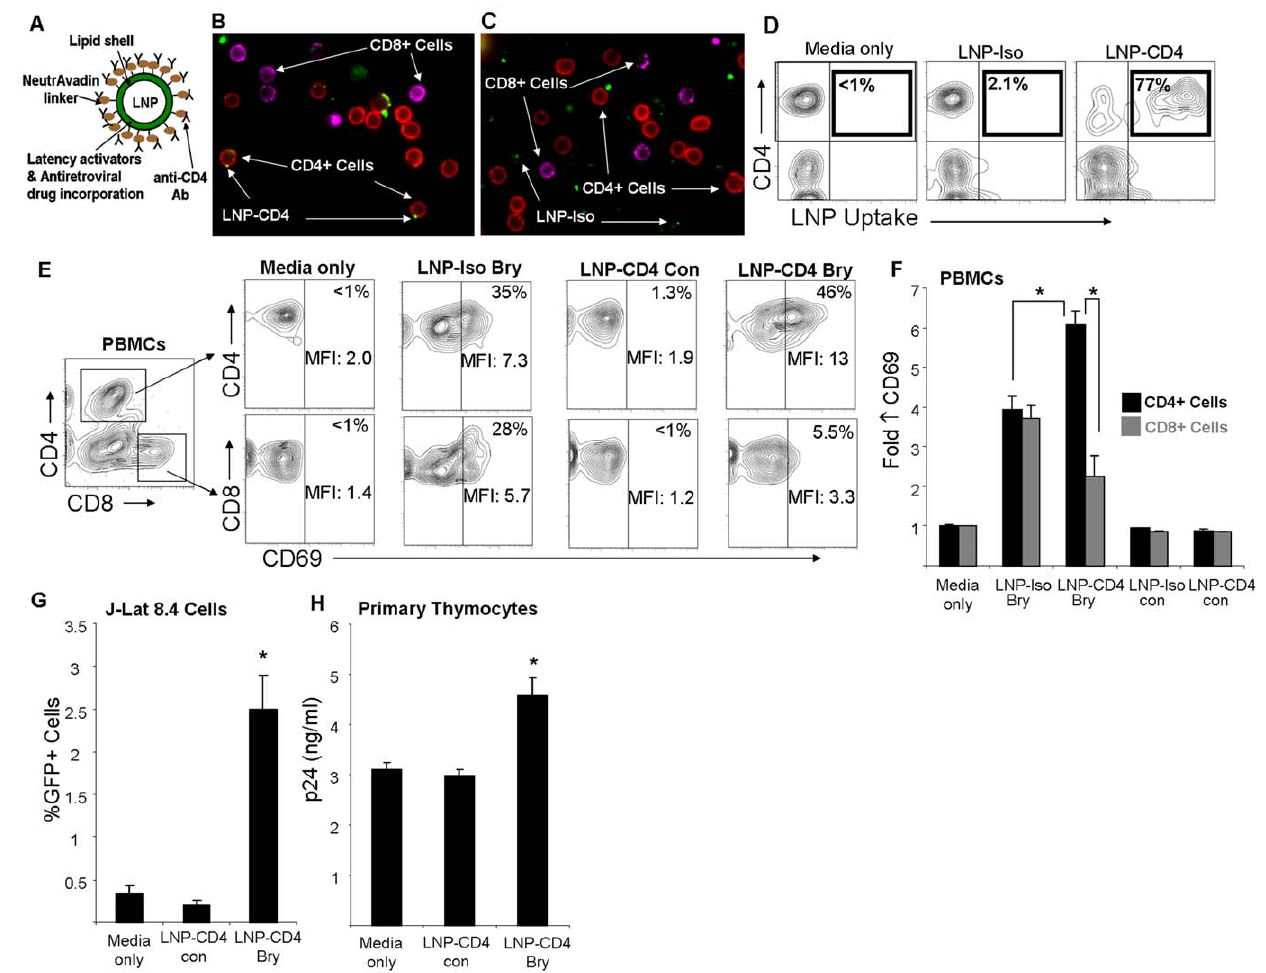
Figure 4. Targeting LNP to primary CD4 + cells and activation of latent virus expression. (A) Schematic representation showing construction of the LNP-CD4 (anti-CD4 coated nanoparticles) and LNP-Iso (isotype control antibody coated nanoparticles) with bryostatin-2 incorporation. (B) Fluorescent microscopy image displaying the targeting of LNP-CD4 (green) to CD4 + cells (red) while minimizing cellular association with CD8 + cells (violet) in the same culture of total peripheral blood mononuclear cells (PBMCs) after a 30 min exposure. (C) Fluorescent microscopy image displaying the lack of targeting by LNP-Iso (green) to CD4 + cells (red) or CD8 + cells (violet). (D) Quantification of LNP-CD4 uptake in PBMCs using flow cytometry (% cells CD4 + with increase in FITC-LNP uptake) after a 30 min exposure. (E) Representative flow cytometry plots of CD4 + and CD8 + cells analyzed for the induction of the early activation marker CD69 after incubation with CD4 targeting nanoparticles for 16 hr. (F) Bar graphs illustrating the fold increase in CD69 MFI in CD4 + and CD8 + cells after incubation with LNP-CD4 Bry. (G) LNP-CD4 Bry was further tested for its ability to stimulate latent virus expression in J-Lat 8.4 cells. (H) Ex vivo CD4 single-positive thymocytes isolated from infected SCID-hu (Thy/Liv) implants were incubated with LNP-CD4 Bry and viral p24 protein present in the culture supernatants was analyzed after 48 hr. Error bars indicate the standard deviation of triplicate data points and are representative of at least 2 experiments. * p , 0.01 in a paired t-test as indicted in (F) and as compared with media only or LNP-con in (G) and